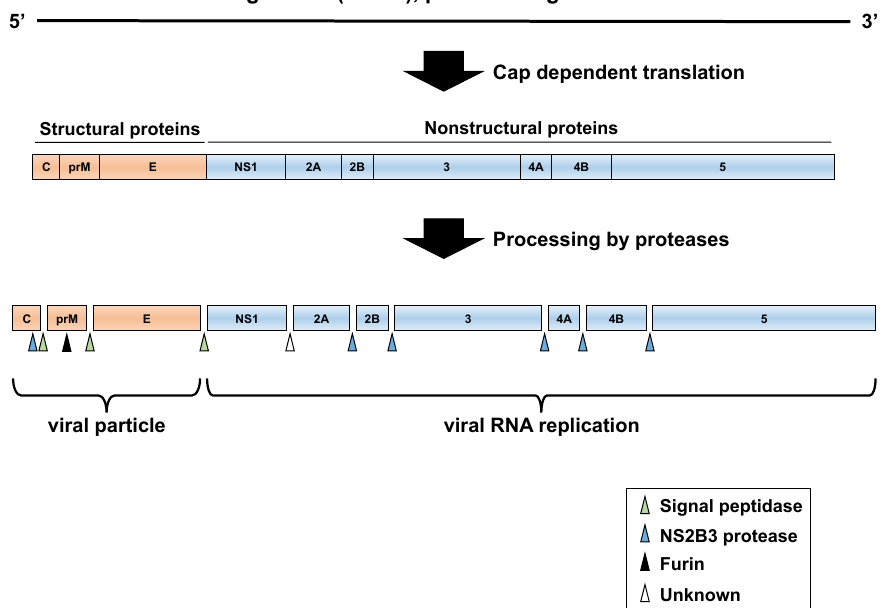
Figure 2. Schematic diagram of the DENV genome. The single-stranded viral RNA is translated by cap-dependent initiation scanning of the 5 1 - untranslated region (UTR). The translated polyprotein is processed by cellular and viral proteases into three structural proteins (capsid (C), pre-membrane (prM), and envelope (E) proteins) and seven NS proteins (NS1, NS2A, NS2B, NS3, NS4A, NS4B, and NS5). C, prM, and E proteins constitute the components of viral particles, whereas NS1–5 proteins function in the replication of RNA viral